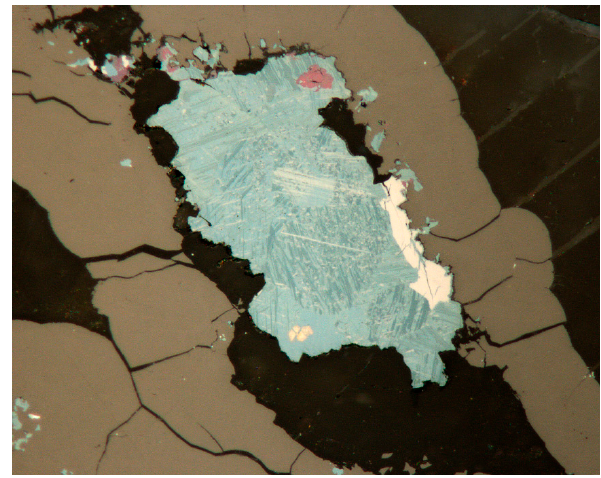
Figure 7. Whitish to dark blue (pleochroism colors) aggregate of athabascaite with creamy white eucairite and very small violet umangite grains. The dark brown uraninite rim surrounds the periphery. Reflected light, one polarizer. Field of view 210 μ m. P ř íbram, a dump of the shaft 16. Photo by P. Škácha.